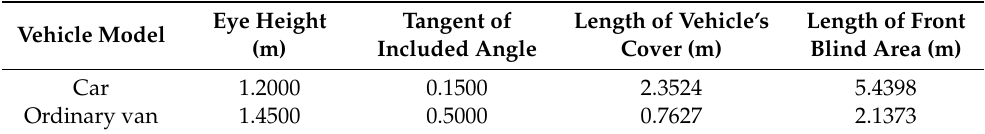
Table 2. Parameters related to driver’s front blind